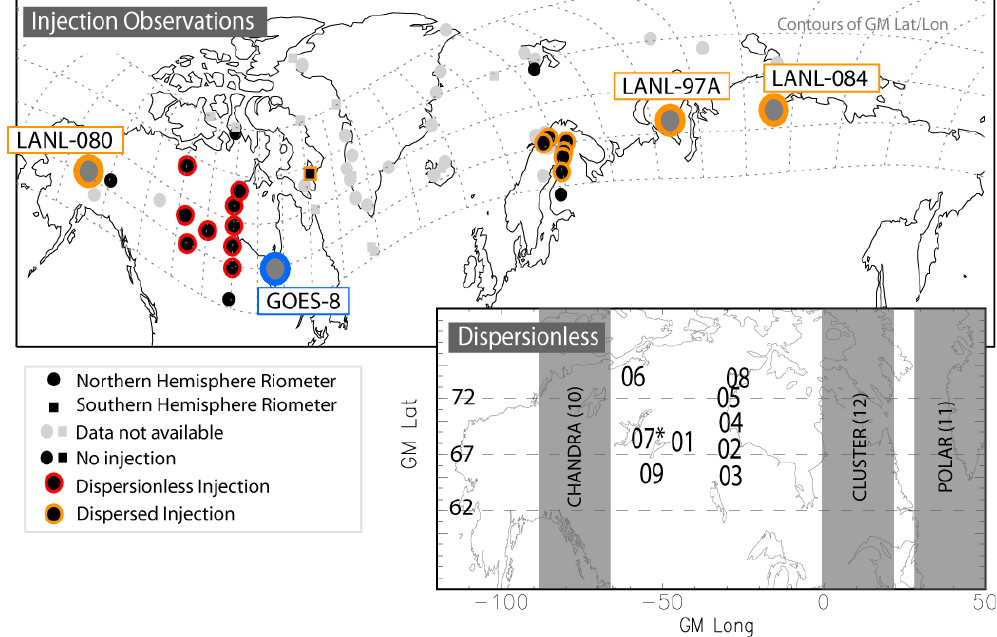
Figure 3. [Top] Locations of all riometers used in this study along with the mappings of GOES-8 and three LANL spacecraft. Stations are colour coded according to the type of injection observed (see legend in bottom left). [Bottom-Right] Timing of the injection seen in the NORSTAR array. Stations are numbered according to Figure 2, the order in which a dispersionless injection was observed. We also show the GM meridians for Chandra, Polar and Cluster (note: these are not mapped using a field line model).